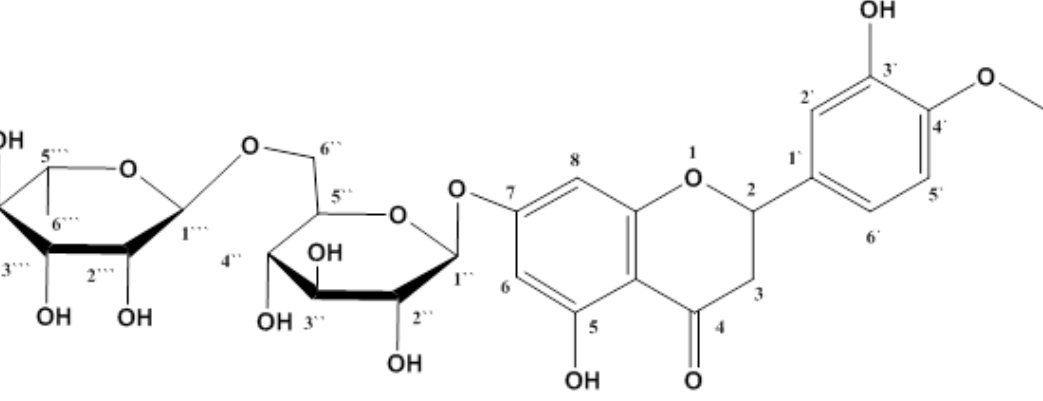
Figure 1. Structure of isolated pure hesperidin from TME of O. forskolei .